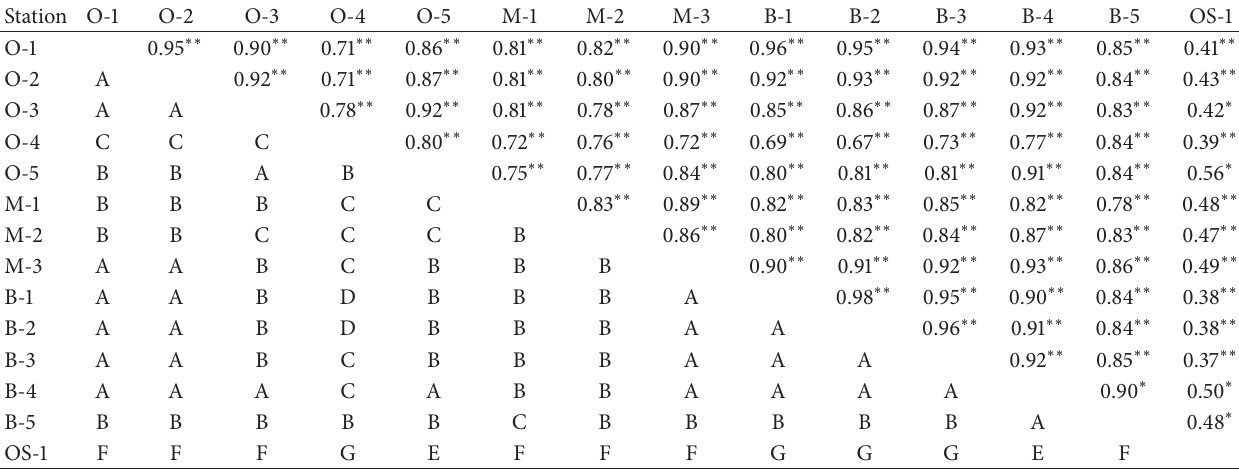
Table 5: 𝑝 value and quality for correlation coefficients for O Nanmadol invading case.